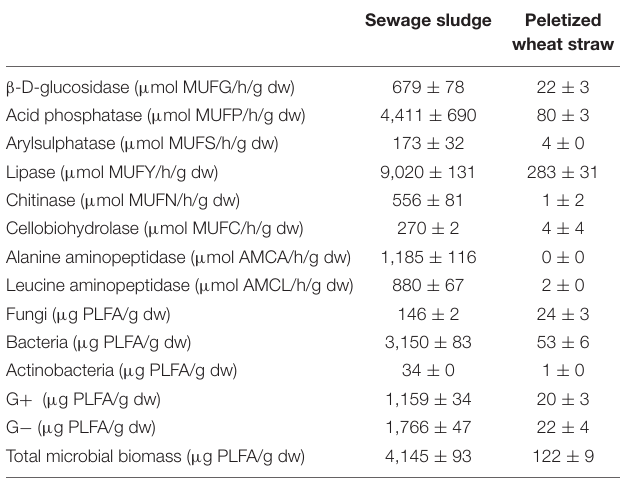
TABLE 1 | Enzymatic activity and content of microorganisms in input raw